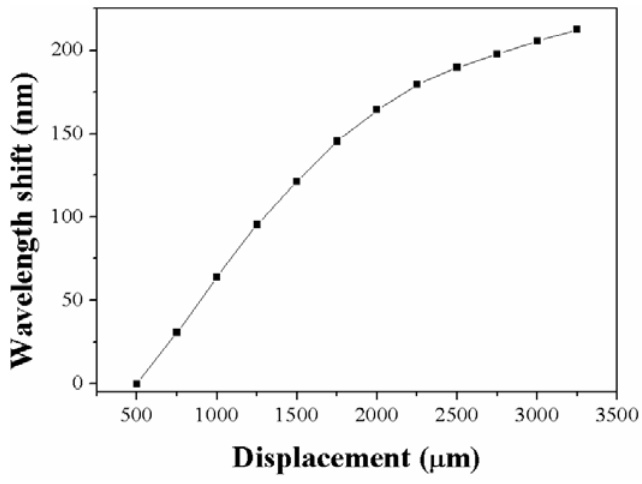
Figure 10. Wavelength shift as a function displacement distance for a loop displacement sensor made with a 3 mm transition length, 30 mm waist length, and 35 μ m waist diameter of taper.